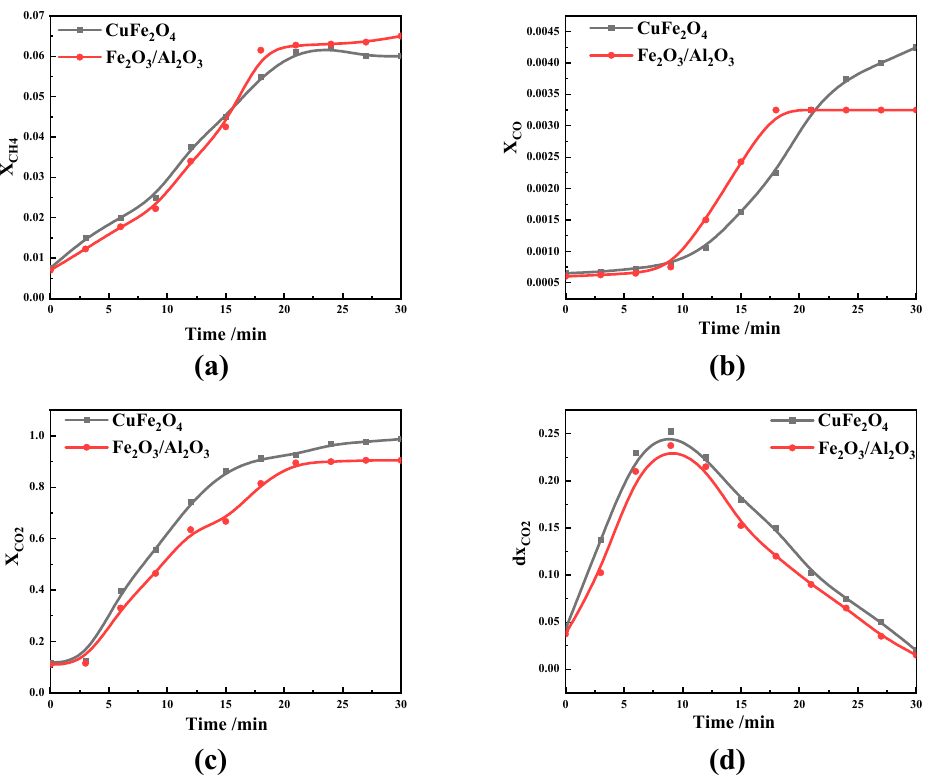
Figure 14. Trend of ( a ) CH 4 , ( b ) CO, ( c ) CO 2 and ( d ) dx CO2 over time of iron-based OC and CuFe 2 O 4 during CLC.